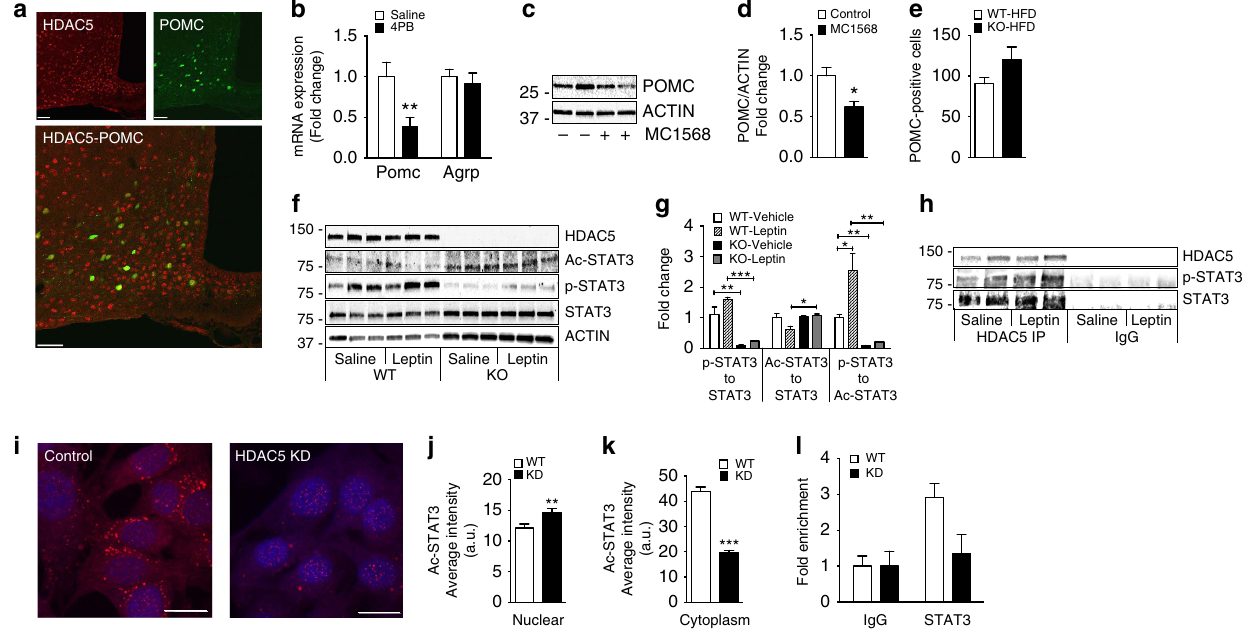
Figure 4 | Hypothalamic disruption of HDAC5 activity impairs POMC expression and STAT3 signalling: ( a ) Hypothalamic slices of male POMC–GFP mice were subjected to immunostaining with anti-rabbit HDAC5 antibody, and revealed widespread HDAC5 expression and colocalization to B 68.62% of all POMC neurons. ( n ¼ 4 slices, Scale bar, 50 m m) ( b ) Hypothalamic mRNA levels of Pomc and Agrp in rats 2h after 3rd ventricular injection of 4-phenylbutyric acid (4-PB) or vehicle ( n ¼ 8). ( c , d ) Western blot and densitometric analysis of POMC and ACTIN protein levels in CLU177 cells 24h after